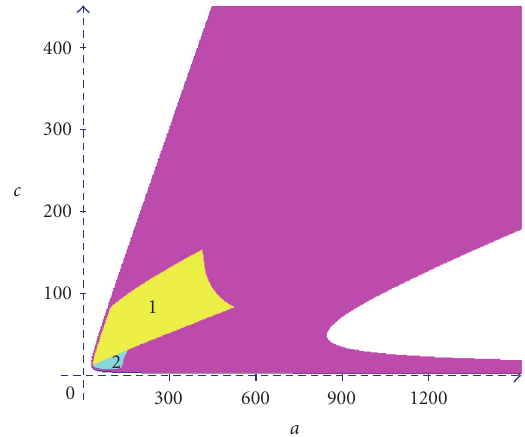
Figure 5.4 . Region of su ffi cient stability condition for (5.2): p = 12, h = 0 . 024, Δ = 0 . 012.